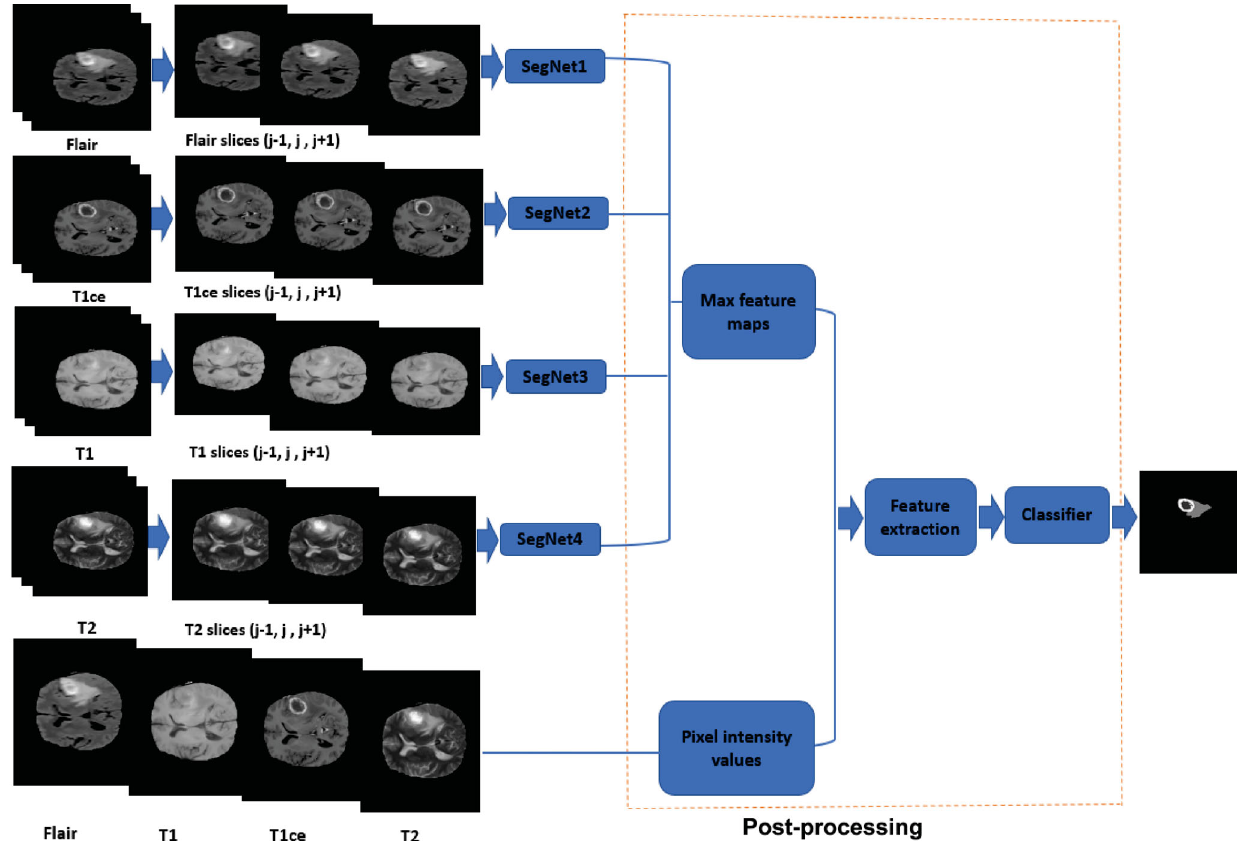
Fig. 1 Pipeline of our brain tumour segmentation approach.